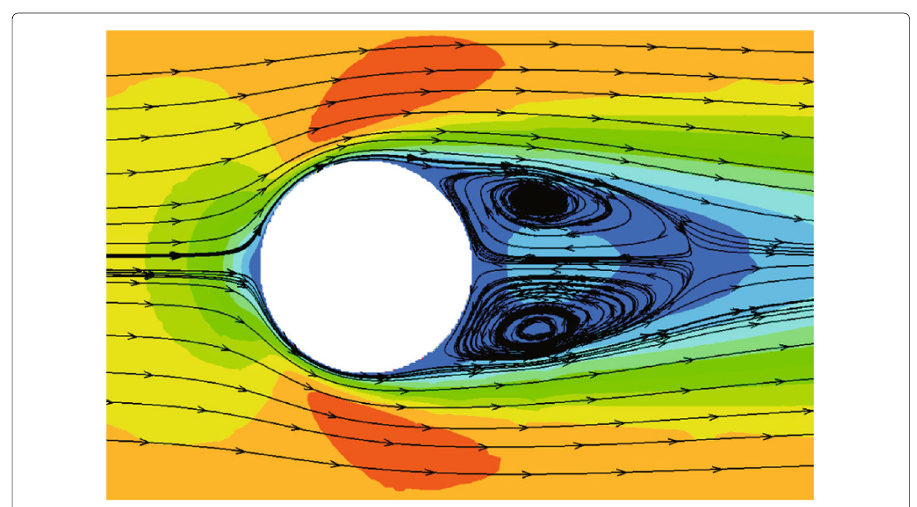
Fig. 26 Streamlines and Mach number contours for subsonic flow around a sphere ( Z = 0 )